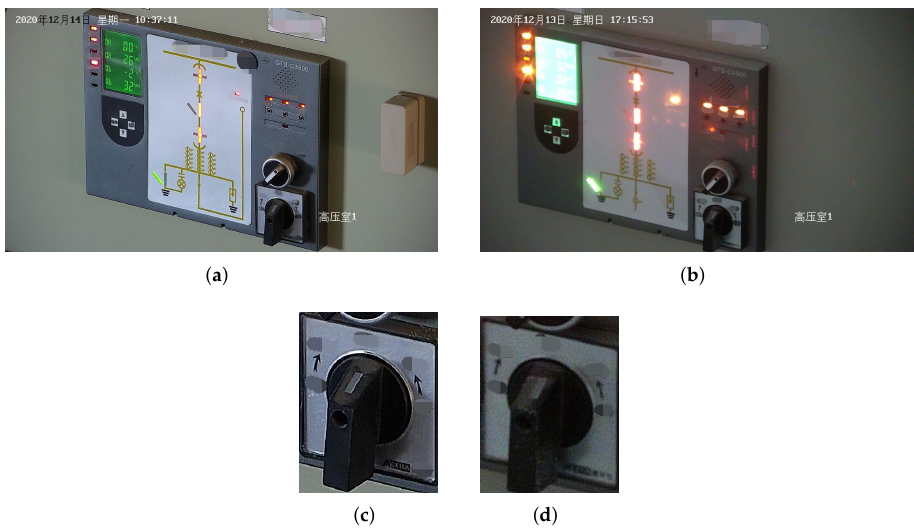
Figure 1. Images under different lighting conditions. ( a ) Image with good lighting conditions. The upper left corner of the image shows the time of acquisition: Monday, 14 December 2020. The lower right corner of the picture shows the location of the acquisition: the first hyperbaric chamber. ( b ) Image with poor lighting conditions. The upper left corner of the image shows the time of collection: Sunday, 13 December 2020. The lower right corner of the picture shows the location of the acquisition: the first hyperbaric chamber. ( c ) Knob image cropped from ( a ) with high SNR. ( d ) Knob image cropped from ( b ) with low SNR.